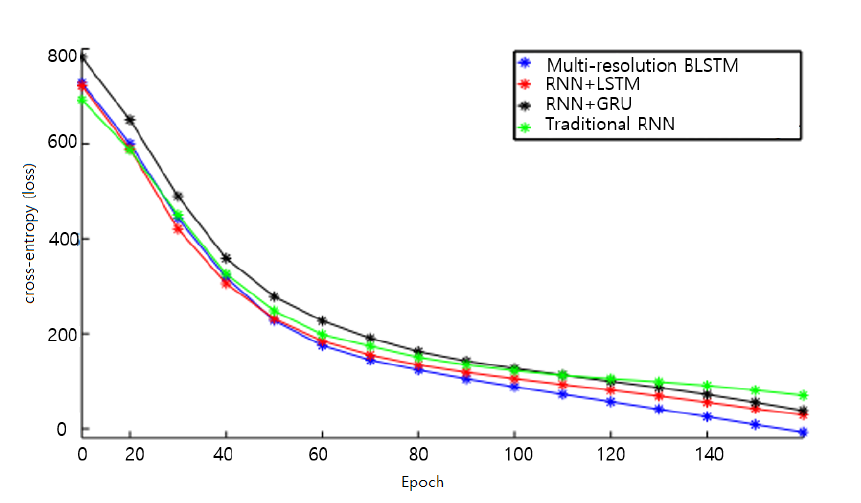
Figure 9. Comparison of cross-entropy loss per epoch over ECG-ID dataset over conventional and proposed